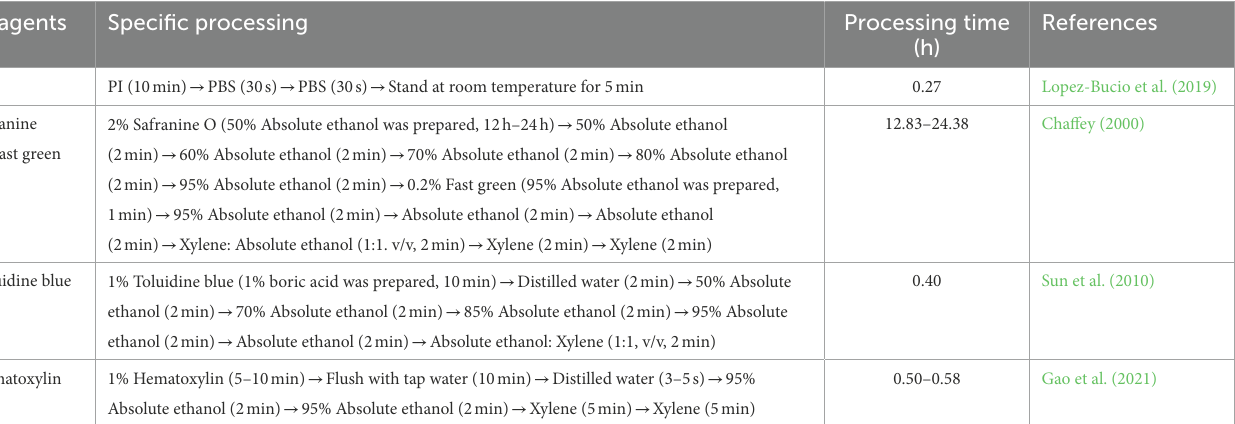
TABLE 3 Comparison of PI dyeing and conventional